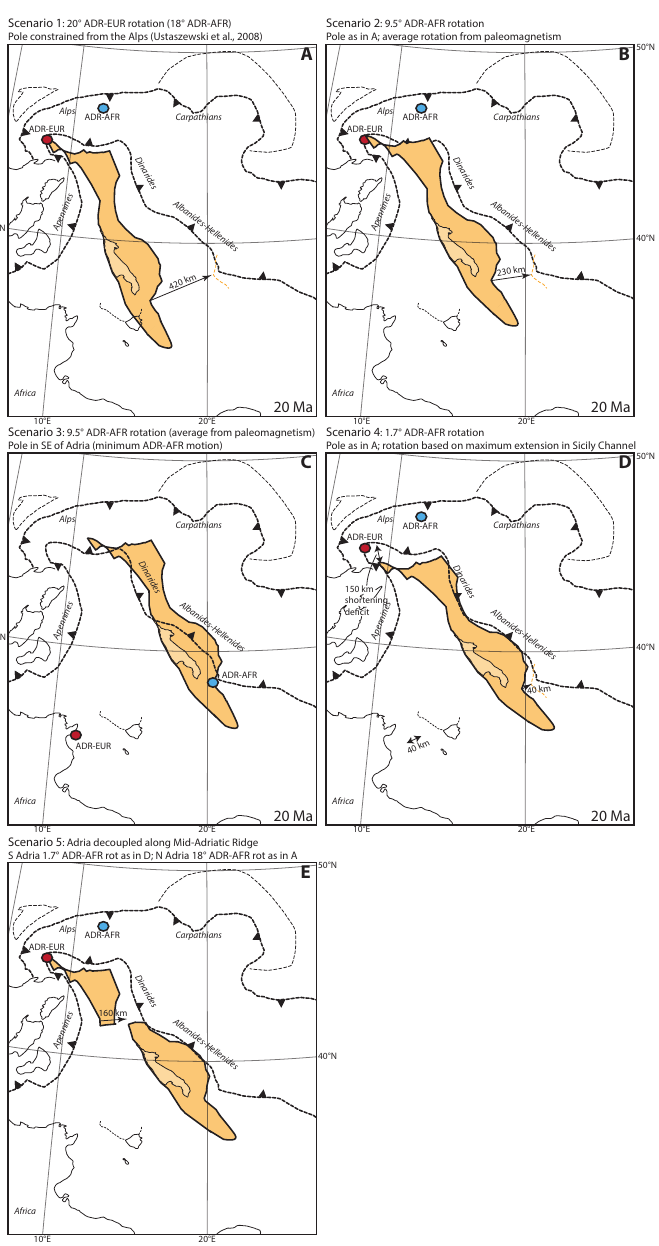
Figure 8. Reconstructions at 20Ma for rotation scenarios of Adria versus Africa that are permitted by paleomagnetic data, using (A) the rotation pole of Adria versus Eurasia of Ustaszewski et al. (2008), and a 20 ◦ ccw rotation of Adria versus Europe, corresponding to 18 ◦ ccw rotation of Adria versus Africa, constrained from shortening reconstructions in the Alps by the same authors; (B) a 9.5 ◦ ccw rotation of Adria versus Africa around the same pole corresponding to the paleomagnetically constrained mean rotation in this paper; (C) a 9.5 ◦ ccw rotation of Adria versus Africa corresponding to the paleomagnetically constrained mean rotation in this paper, around a pole located in the SE of Adria and allowing minimum relative latitudinal motion between Africa and Adria; (D) a 1.7 ◦ ccw rotation of Adria versus Africa around the pole of Ustaszewski et al. (2008), corresponding to the maximum amount of Neogene extension documented in the Sicily Channel; (E) decoupling northern and southern Adria along the Mid-Adriatic Ridge of Scisciani and Calamita (2009), with northern Adria following a scenario as in (A) , and southern Adria following a scenario as in (D) . Reconstructions of (i) the Adriatic front of the Alps, Carpathians and Dinarides follow Ustaszewski et al. (2008), (ii) the western Mediterranean region follow Faccenna et al. (2004) and van Hinsbergen et al. (2014), and (iii) the Aegean–Albanian region follow van Hinsbergen and Schmid (2012). Reconstruction is given in a Europe-fixed frame, with the position of Africa determined using rotation poles of Gaina et al. (2002) and Müller et al. (1999) for the North Atlantic and central Atlantic Ocean,